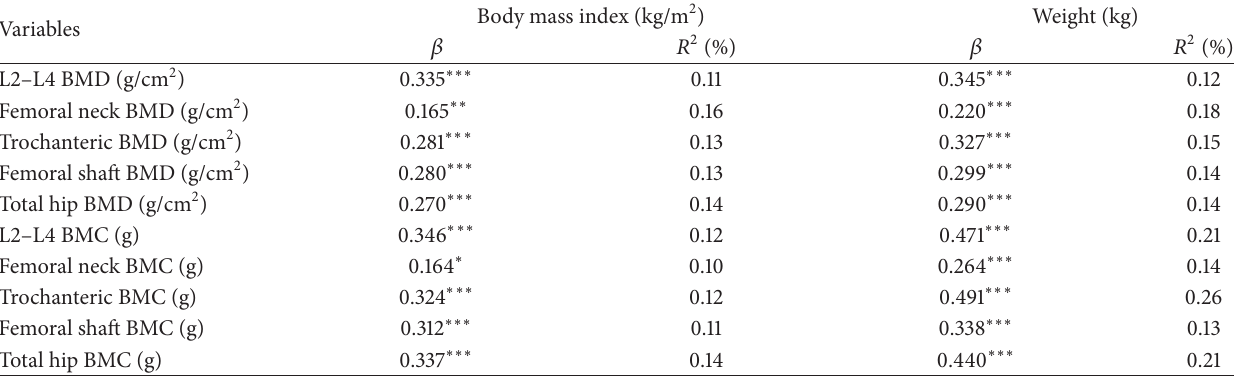
Table 5: Age-adjusted linear regression analysis for BMD and BMC with BMI and weight as regressor.